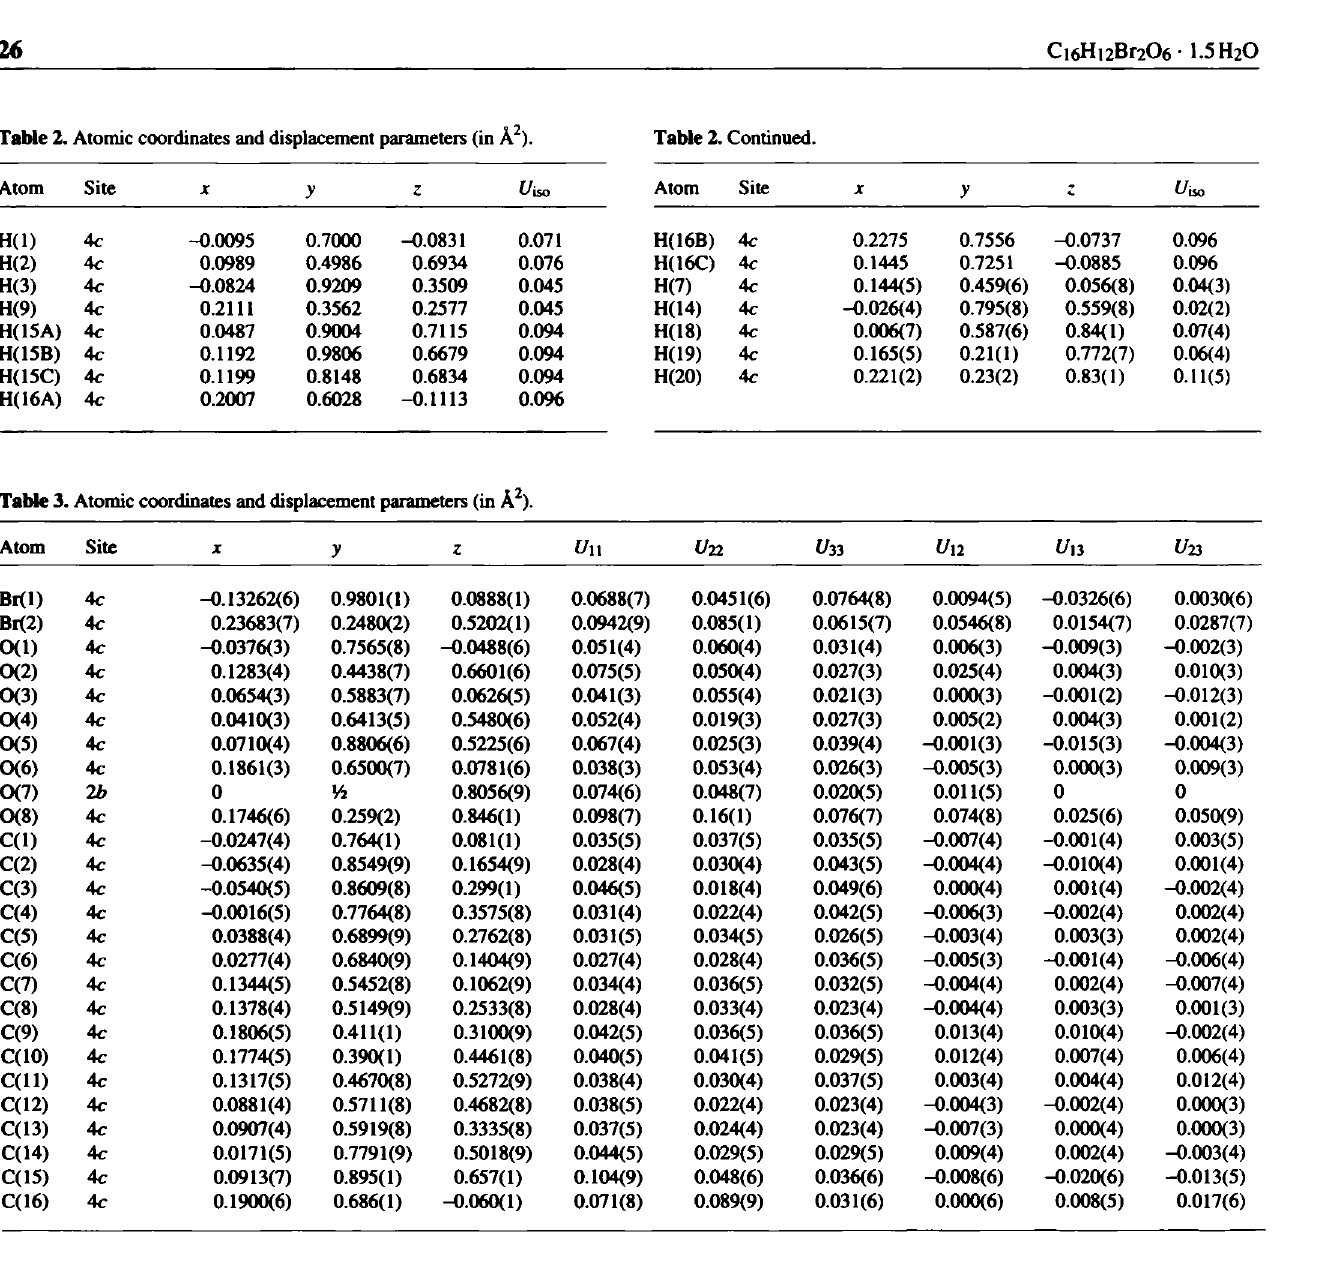
Table 2. Atomic coordinates and displacement parameters (in Ä 2 ). Table 2. Continued.